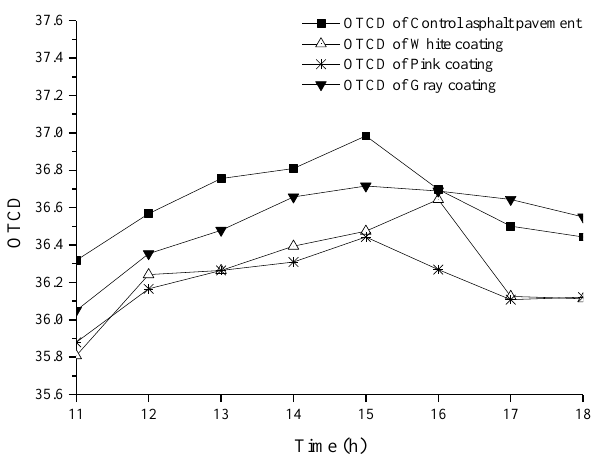
Figure 17. Comparison on outdoor thermal comfortable degree (OTCD) between heat-reflective coatings and control asphalt pavement.